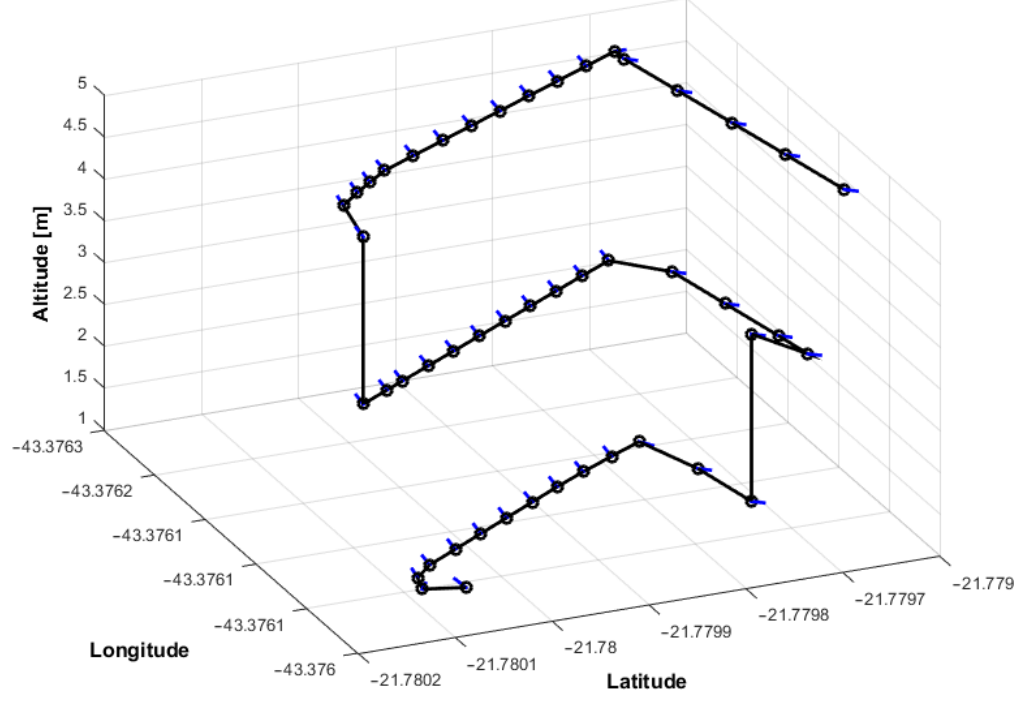
Figure 16. Initial Mission in the